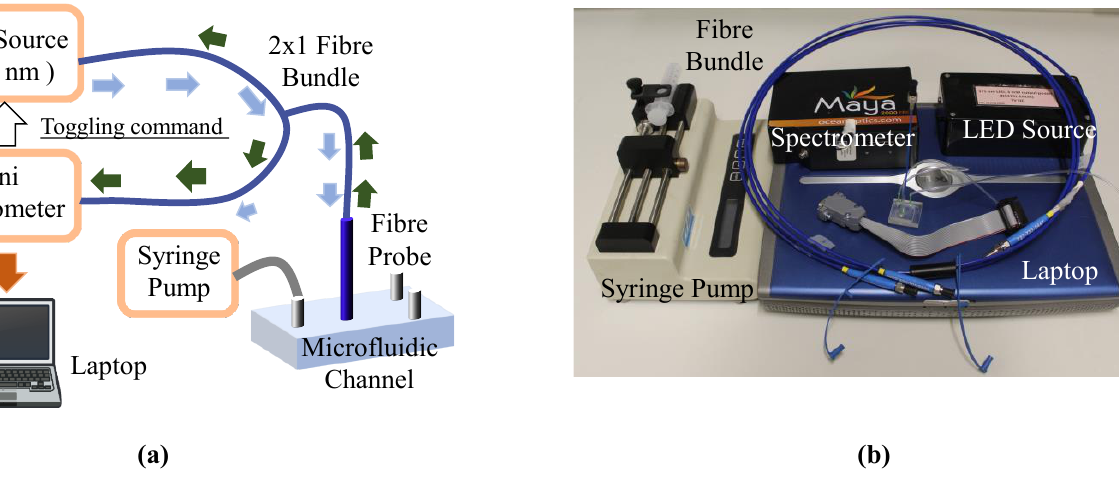
Figure 3. ( a ) Schematic of the experimental setup. Toggling of LED was controlled by sending pulse signal to electromechanical relay using a spectrometer. ( b ) Photograph showing several of the important components used in the setup.